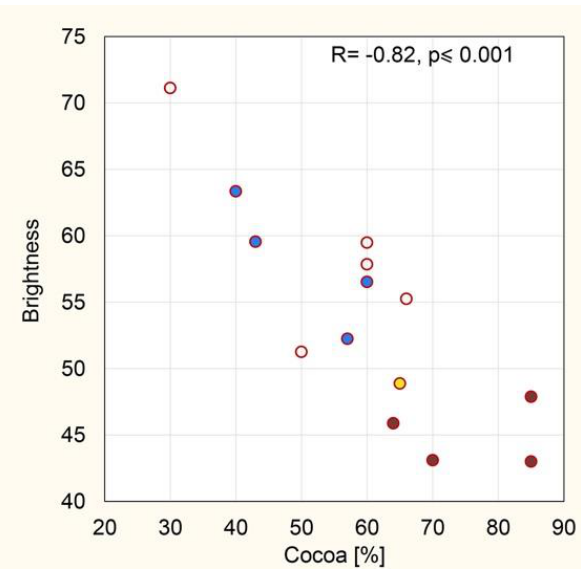
Figure 3. Correlation between the brightness of the chocolate and the cocoa content in the chocolate. Brown dark chocolate, blue milk chocolate, white dessert chocolate, yellow Viminella. The reflectance of chocolate is very much dependent on the brightness of the choco- late (Figure 4). It was shown that the brighter the chocolate, the higher the reflectance. This dependence was observed for almost all ranges of wavelength, except for the wave- length in the range of 1700–2500 nm. Taking into account the other wavelength ranges, the least statistically significant correlation of color and reflectance occurred at the wave- length of 335–380 nm (R = 0.66, p = 0.010). All wavelength ranges from 400 to 1700 nm showed a highly significant, very strong correlation between color and reflectance (R ≥ 0.80, p ≤